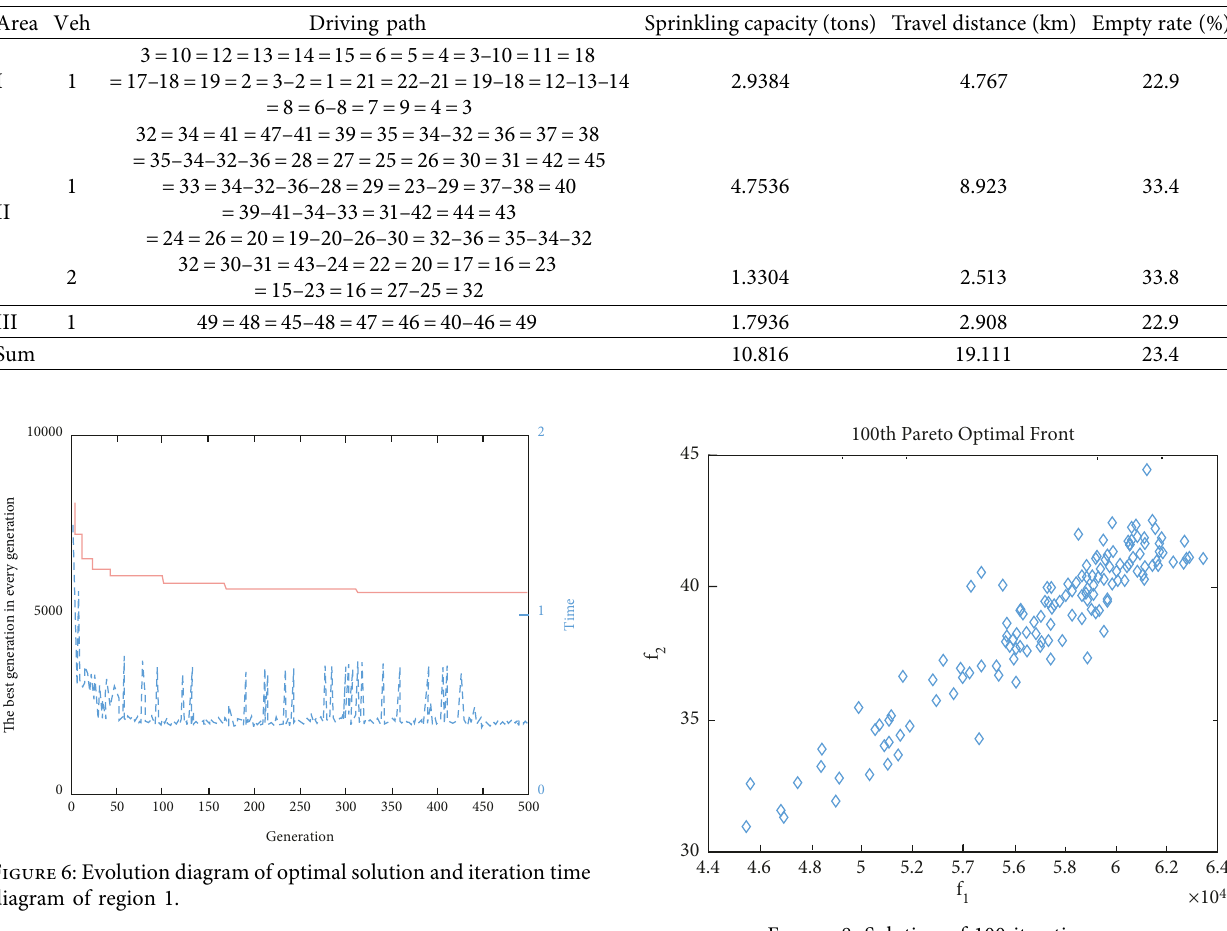
Table 3: Detailed description of multiple depots.